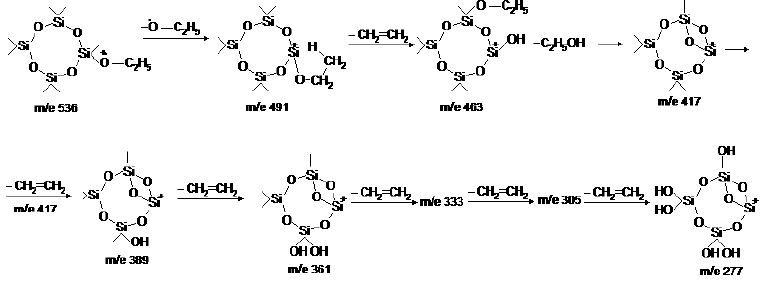
Figure 4. The reactions for obtaining the fragmentation ion m/e 277 from molecular ion at m/e 536. The m/e ion 277 with the ionic formula H 5 O 10 Si 4 is characteristic ion for bicyclic, cyclic, branched, cyclic, branched, and linear tetramers and can be used to identify and measure the TEOS tetramer fraction. The existence of this ion is argued by the M+1 and M+2 isotopic effects for the molecular species of tetramers of TEOS [1–3]. There is a good agreement between the experimental values for the ion with m/e 277 and intensity 76.0% (14,3% and 11.8%) in the mass spectrum of CTET and those calculated theoretically by MS Interpreter software (15.5% and 12.6%)